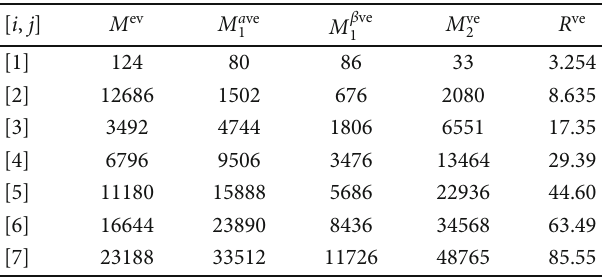
- II ½ i , j (cid:2) . 4